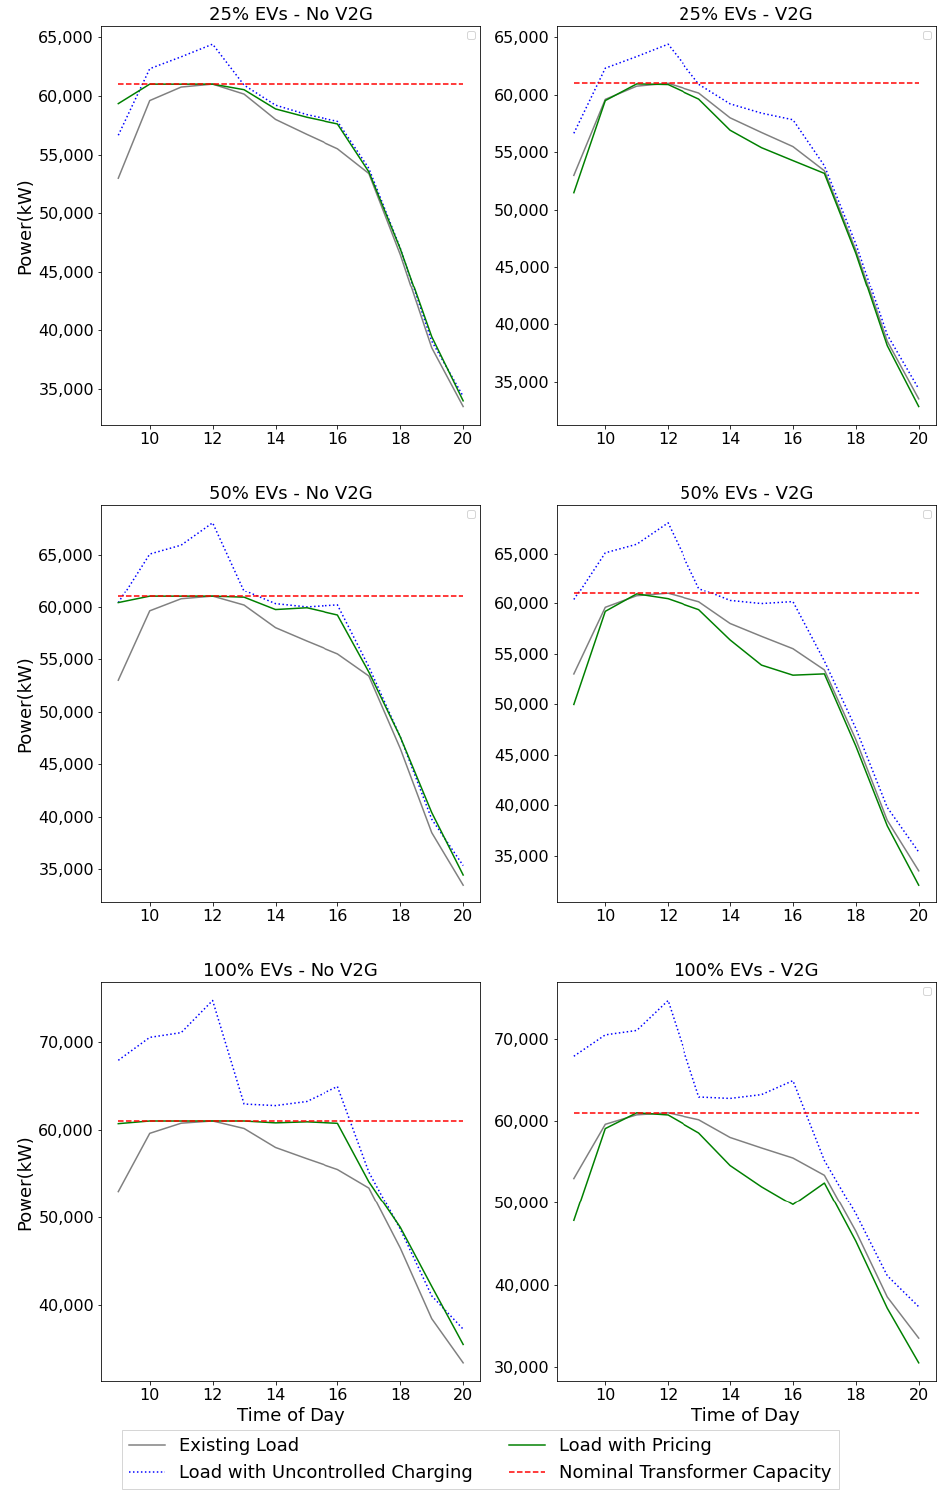
Figure 10. Charging allocation analysis for EV market penetration and V2G availability (Canary Wharf area and 0% overload capacity). The red dotted line represents the nominal capacity of the distribution transformer; the grey line, the baseline load demand; the blue dotted line, the uncoordinated charging scenario; and the green line, the charging allocation with Fixed Pricing based on time of day (FP).